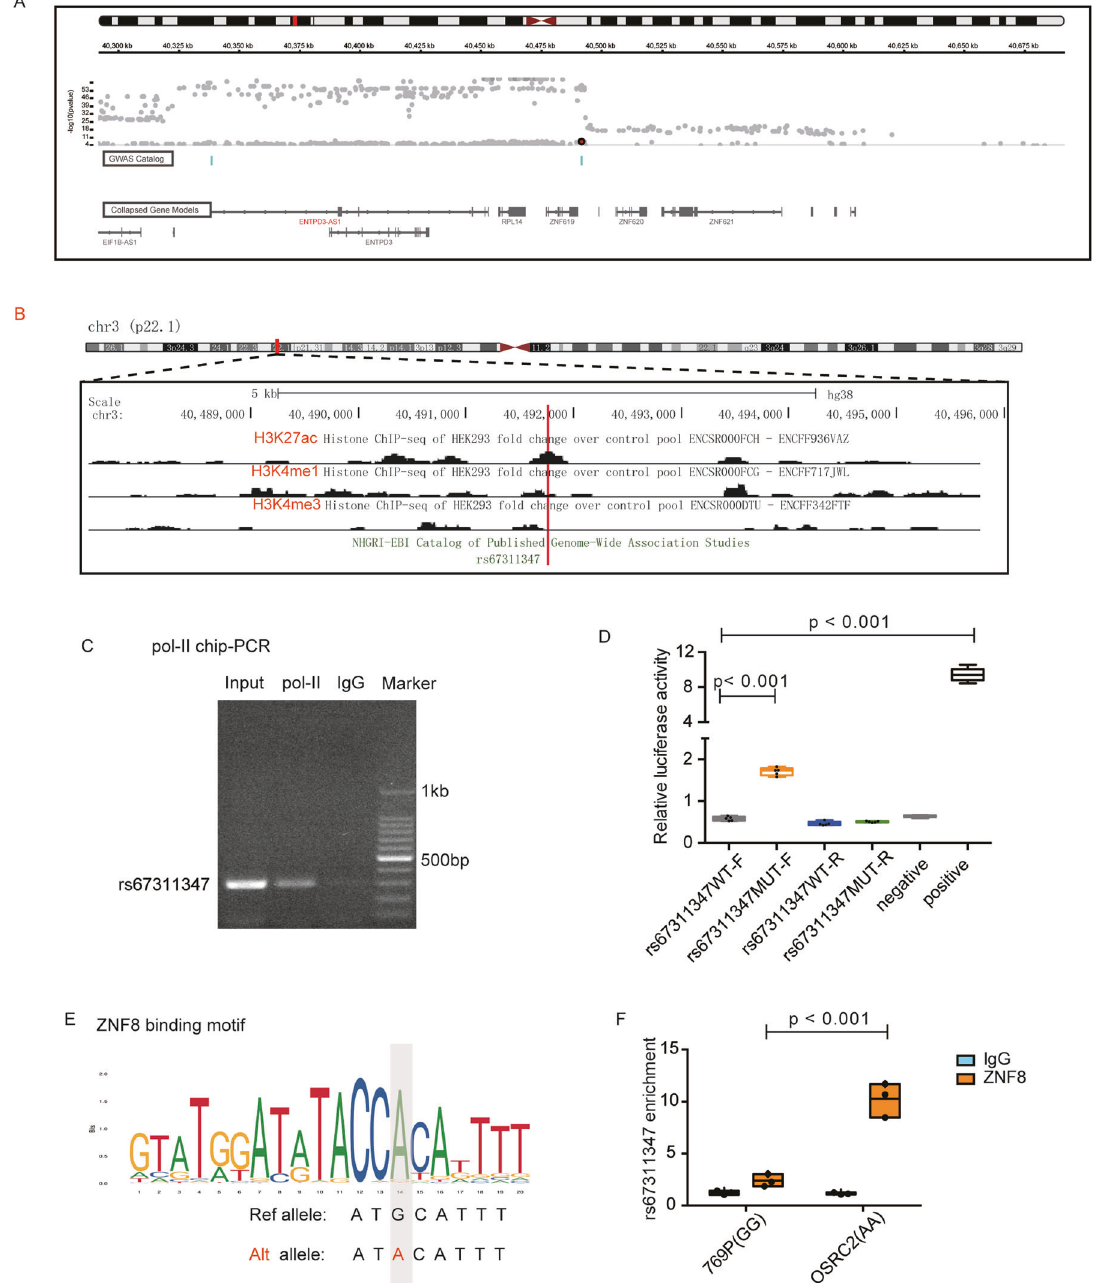
Fig. 2 SNP rs67311347 regulated the expression of lncRNA ENTPD3-AS1 as an enhancer. A The genomic location of rs67311347 and ENTPD3-AS1. B Epigenetic tracks obtained from ENCODE database showed the enrichment of enhancer marks (H3K27ac peaks, H3K4me1 peaks) and transcription marks (H3K4me3 peaks) in the rs67311347 region. C The Polymerase II ChIP-PCR showed that Polymerase II occupied the rs67311347 region. D Relative reporter gene activity of the constructs containing the WTor Mut allele of rs67311347 in forward orientation in A498 cells. E The altered allele A of rs67311347 created a ZNF8 binding motif. F ChIP-qPCR of ZNF8 in RCC cell lines carrying different genotypes of patients (HR = 0.5, p < 0.001) (Fig. 3B, Fig. S3B). To further con fi rm the results, the clinical and expression data from cohort 1 were analyzed. As expected, ENTPD3-AS1 expression was decreased in RCC tissues compared to corresponding normal tissues, and high ENTPD3-AS1 expression predicted a good prognosis (Fig. 3C, D). Besides, the clinicopathological analysis in cohort 1 demonstrated that ENTPD3- AS1 expression was negatively correlated to pT stage and AJCC stage (Fig. 3F), and the AUC of ENTPD3-AS1 expression combined with AJCC stage reached 0.832 in the ROC in cohort 1 (Fig. 3E).